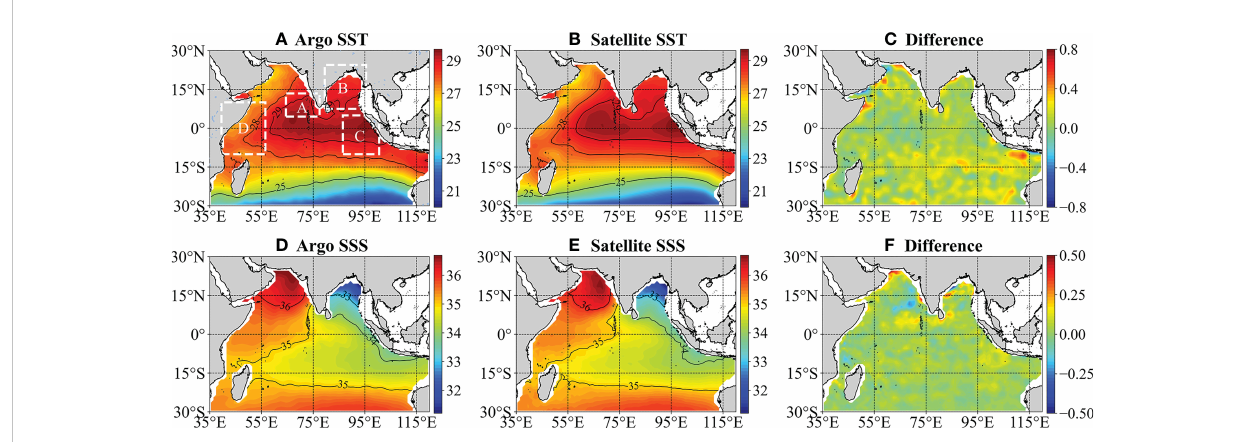
FIGURE 3 Long-term annual mean SST and SSS from Argo (left panel: A , D ) and satellite observations (middle panel: B , E ), as well as the differences between the two (right panel: C , F ) in the tropical Indian Ocean from January 2010 to December 2020. Boxes (A – D) represent four boxes used in this study. Box A (64.5°E~76.5°E and 4.5°N~13.5°N), Box B (79.5°E~95.5°E and 7.5°N~23.5°N), Box C (87°E~105°E and 10°S~5°N), and Box D (40°E~55°E and 10° S~10°N).